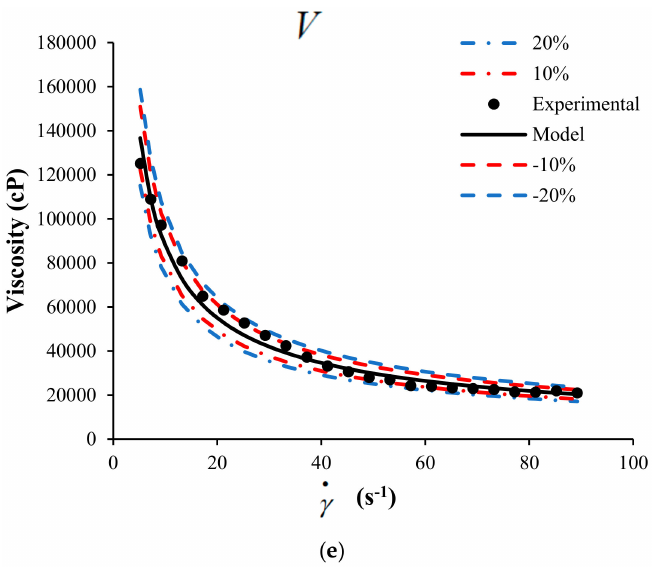
Figure 5. Sensitivity analysis for the HB-MPR parameters ( a ) µ ∞ , γ , ( b ) K H , ( c ) n H , ( d ) K 0 , and ( e ) V .